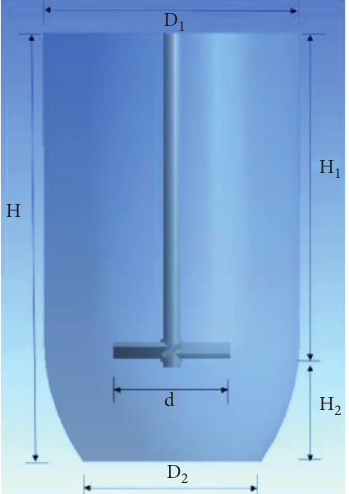
Figure 10: Setup of geometrical of the crucible and stirrer